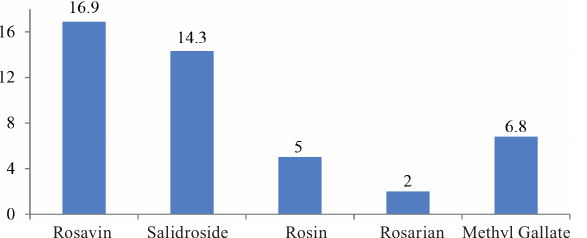
Rosavin Salidroside Rosin Rosarian Methyl G allate Figure 2 Content of biologically active substances in Rhodiola rosea L., mg/g